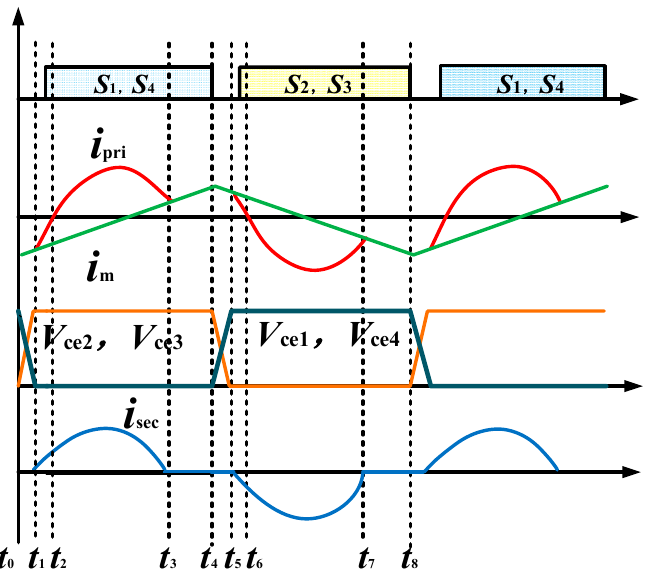
Figure 10. Operating waveforms of the back-end HFI LLC resonant converter.